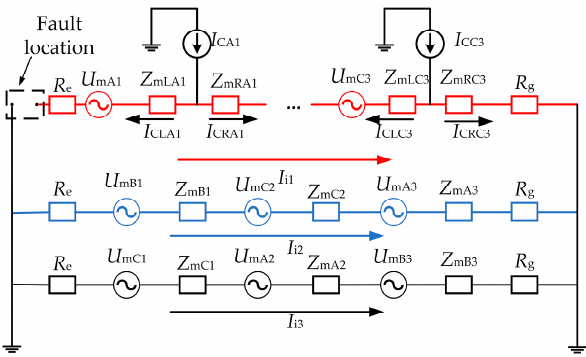
Figure 5. Equivalent circuit diagram of sheath loop L1 open circuit